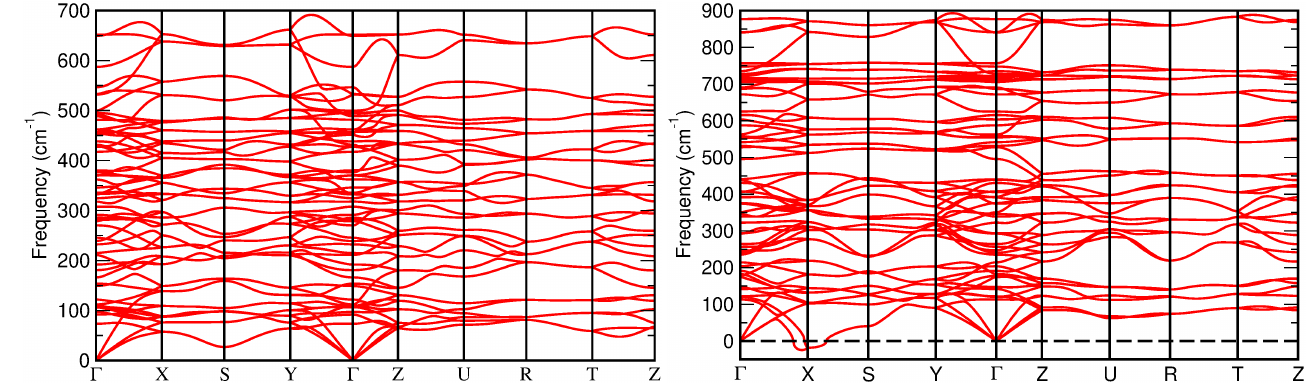
Figure 11. ( left ) Phonon dispersion curves of DyScO 3 perovskite at ambient pressure and ( right ) at 66 GPa.